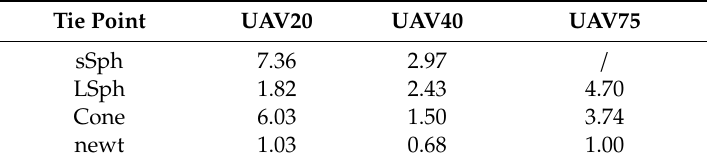
Table 8. The RMSE 3 D on check points, following the registration of UAV and TLS point clouds, taking into account the used tie point (in